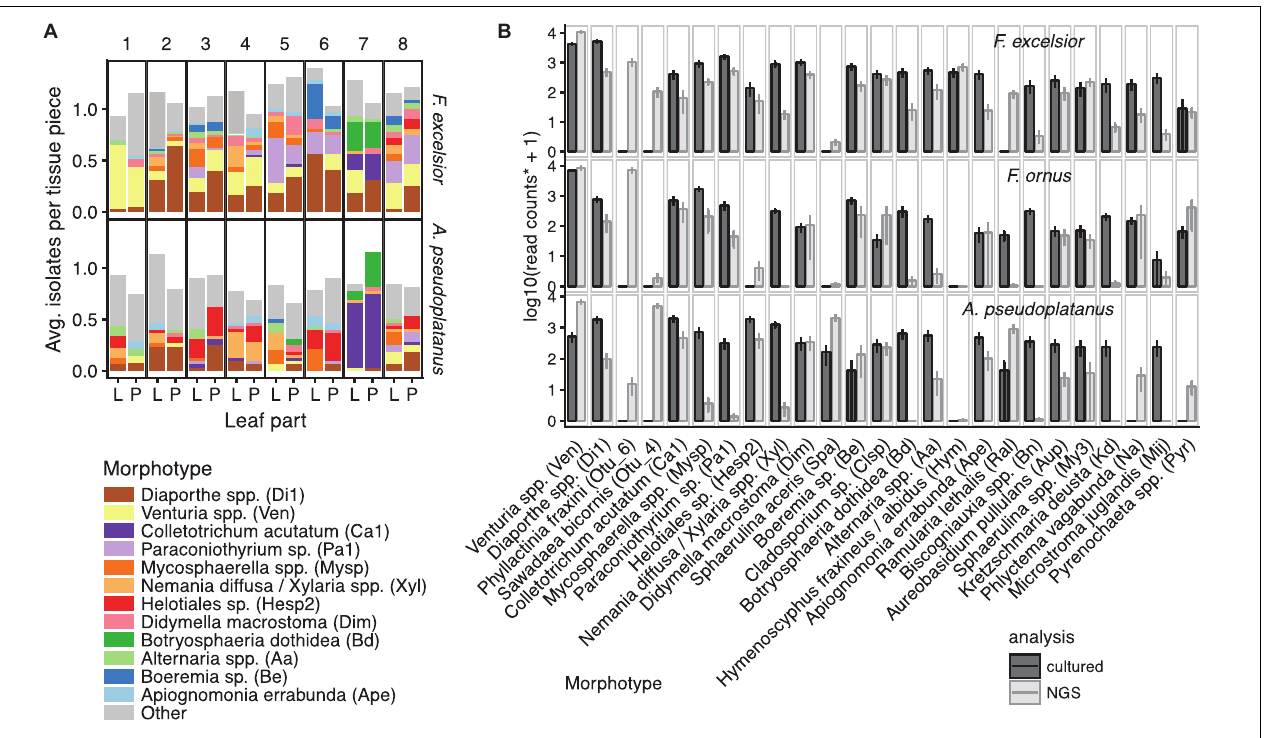
FIGURE 5 | Overview of morphotype abundances. (A) Mean isolation frequencies of the most abundant morphotypes on F. excelsior and A. pseudoplatanus from lamina (L) and petioles (P) per sampling site (number 1–8). Frequencies above one indicate that more than one fungus emerged from one lamina/petiole piece on average. (B) Mean abundances of the most frequent taxa obtained by the culturing method or NGS sequencing. OTUs were considered belonging to a cultured morphotype if they had at least 97% similarity to a sequenced isolate from that morphotype. Additionally, the two most abundant OTUs not found by culture are shown. The morphotype codes are written in brackets. Potentially misassigned sequences (crosstalk) were removed from the NGS dataset. ∗ In order to be comparable with the NGS read counts, the mean relative isolation frequencies from all samples (laminae + petioles) scaled to the average read depth of the scaled NGS samples (20,000). Error bars represent the standard error of the mean (SEM). For isolates from F. ornus , data from Ibrahim et al. (2017) are